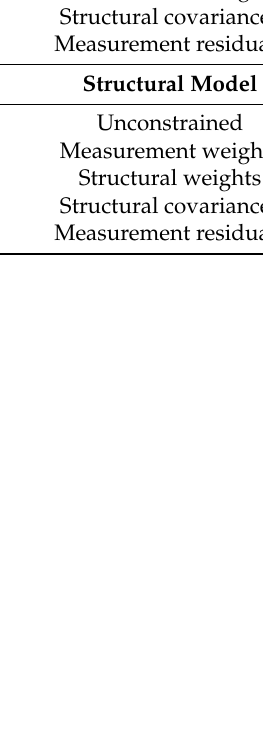
Table 6. Result for the moderating role of